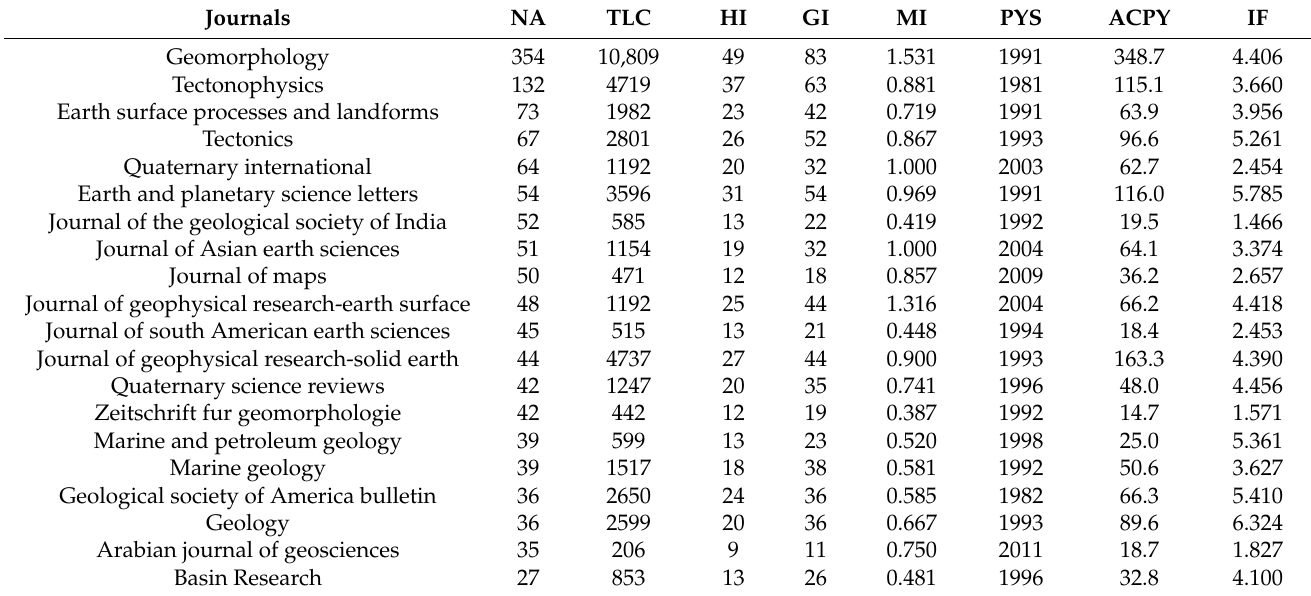
Table 3. Top 20 journals in the tectonic geomorphology research in